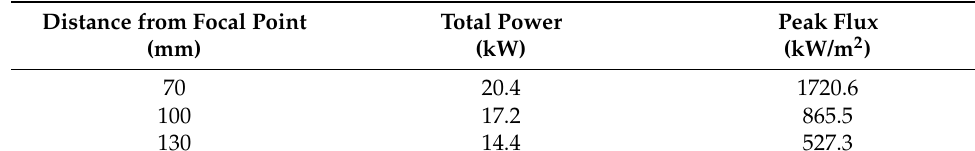
Table 2. Thermal amounts at the reactor surface according to the focal distance.